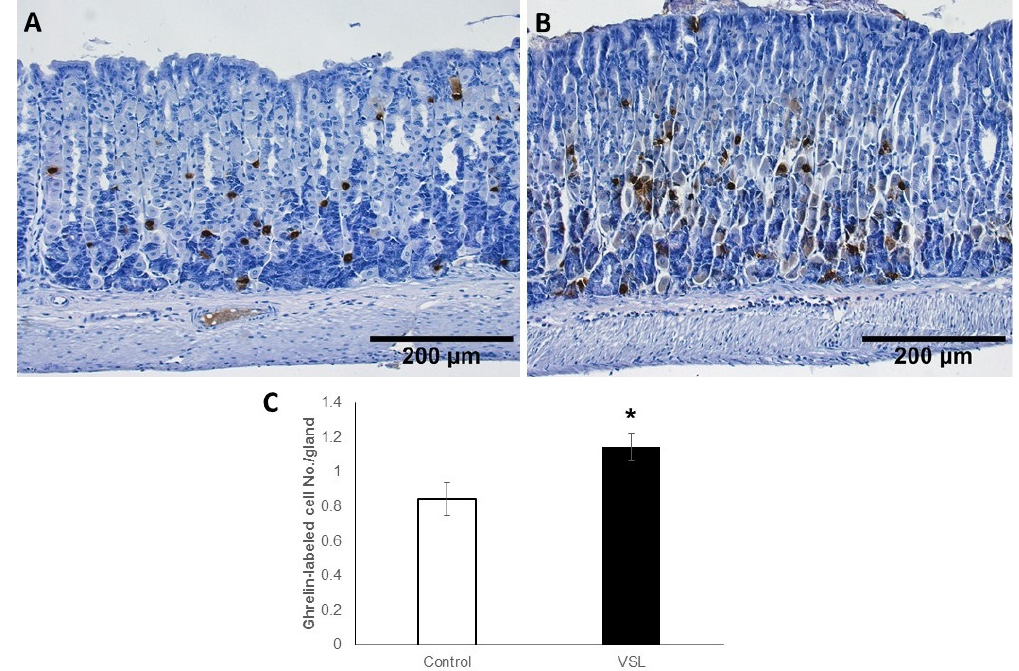
Figure 11. Immunohistochemical analysis of ghrelin-secreting cells in the gastric mucosa of control ( A ) and VSL-treated ( B ) mice. Note the labeled cells scattered along the gastric glands. Magnification bar = 200 µm. Counts of ghrelin-labeled cells per gland in six control and six VSL-mice are presented as mean ± SE ( C ). The asterisk indicates significant increase in VSL-tissues as compared to control. * p < 0.05.